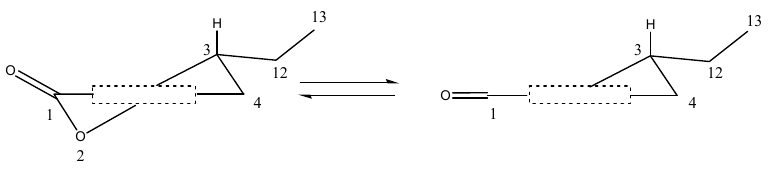
Figure 6. Standard projection from the aromatic into the heterocyclic ring of 1 (half-chair and boat